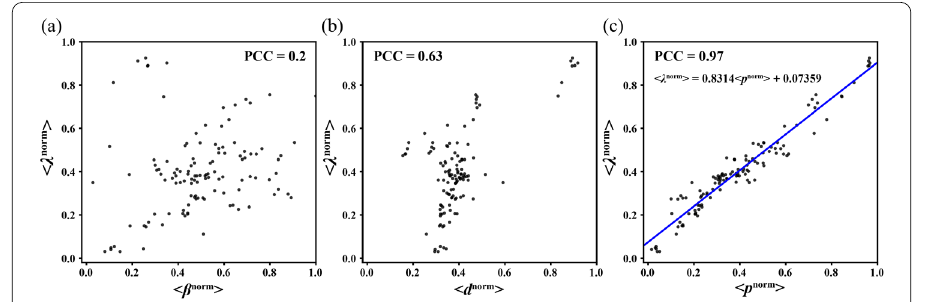
Figure 5 Pearson Correlation Coefficient (PCC) between coupling strength and ( a ) speed ratio, ( b ) average trip distance, and ( c ) fraction of travelers from ordinary zones. The average value of each index across all studied SDNs and time windows is calculated. The blue line in ( c ) denotes the linear regression function